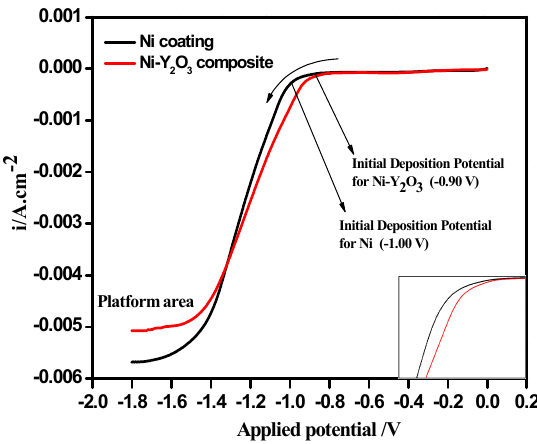
Figure 2. Linear sweep voltammetry (LSV) curves of nickel and composite deposits measured from sulfamate solutions with a scan rate of 20 mV/s, a temperature (T) of 40 °C, and a pH of 4.